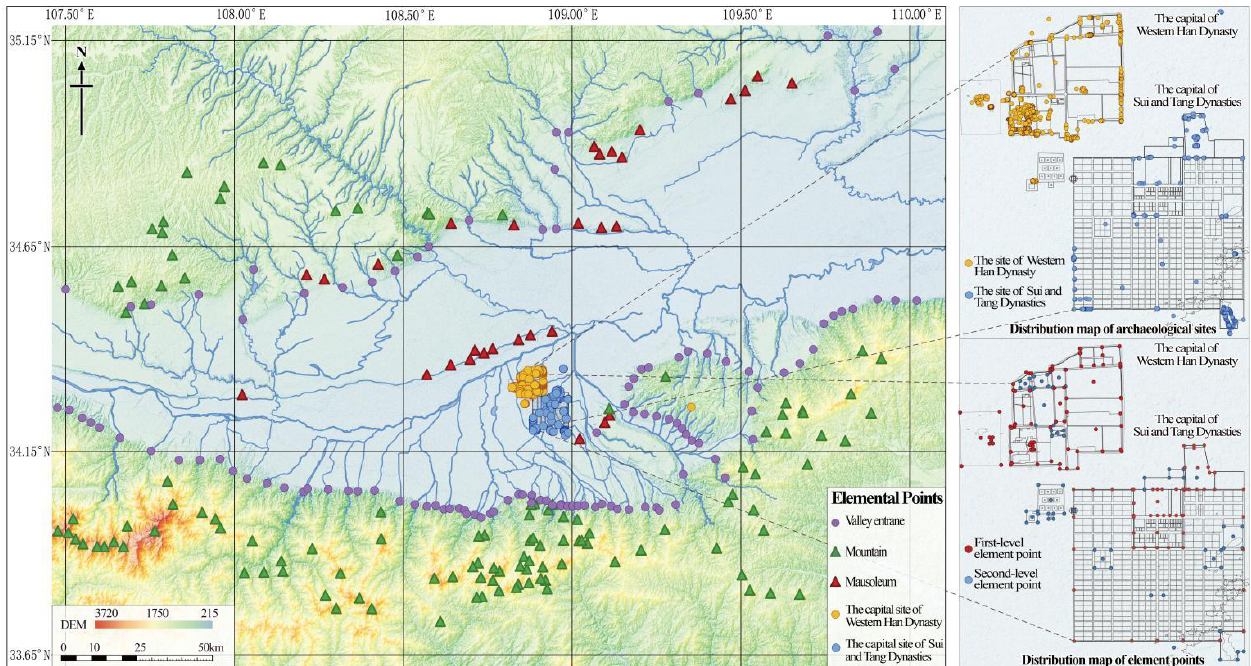
Figure 7. Ichnography of capitals of the Western Han dynasty as well as the Sui and Tang dynasties in addition to the natural environment.